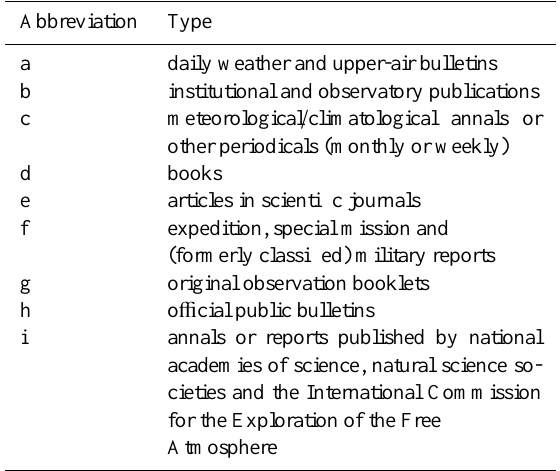
Table 1. Types of data sources